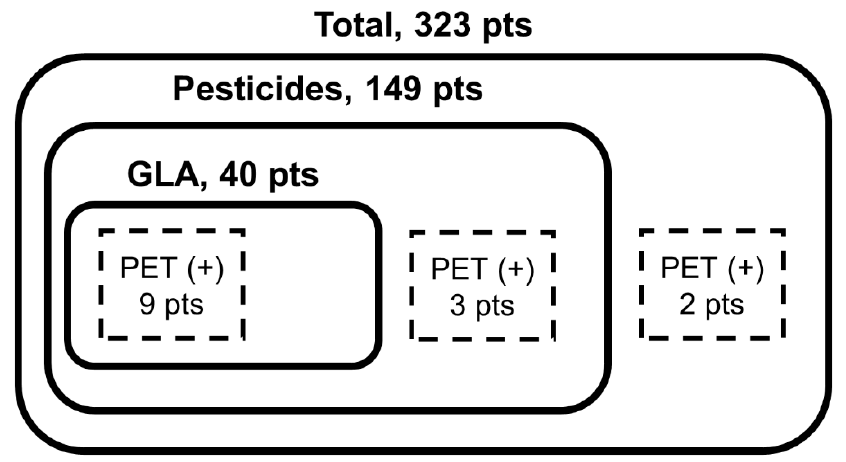
Figure 1. A schema to illustrate the selection process of patients. GLA, glufosinate ammonium; PET, positron emission